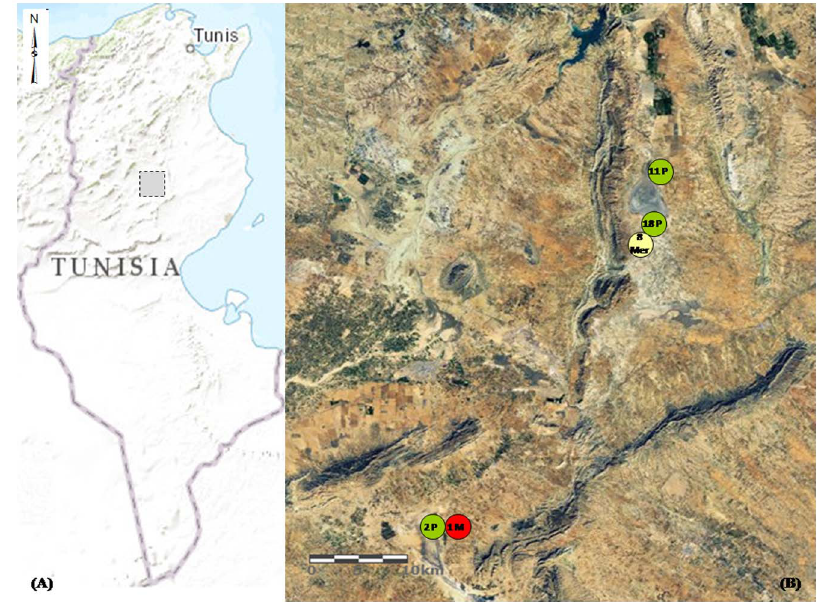
Figure 1. Geographical distribution of strains isolated from the Central Tunisia study area. Panel A shows the square delimited study area in the Governorate of Sidi Bouzid (in gray). Panel B represents the land satellite image of the study area showing the distribution of animal reservoir hosts from which the L. major strains were isolated. Isolates from P. obesus origin were noted P and colored in green, from M. shawi origin were noted Mer and colored in yellow, and from M. nivalis was noted M and colored in red. Spatial data related to the reservoir hosts of these strains were collected using the Global Positioning System (GPS). Satellite imagery: ArcGIS software.